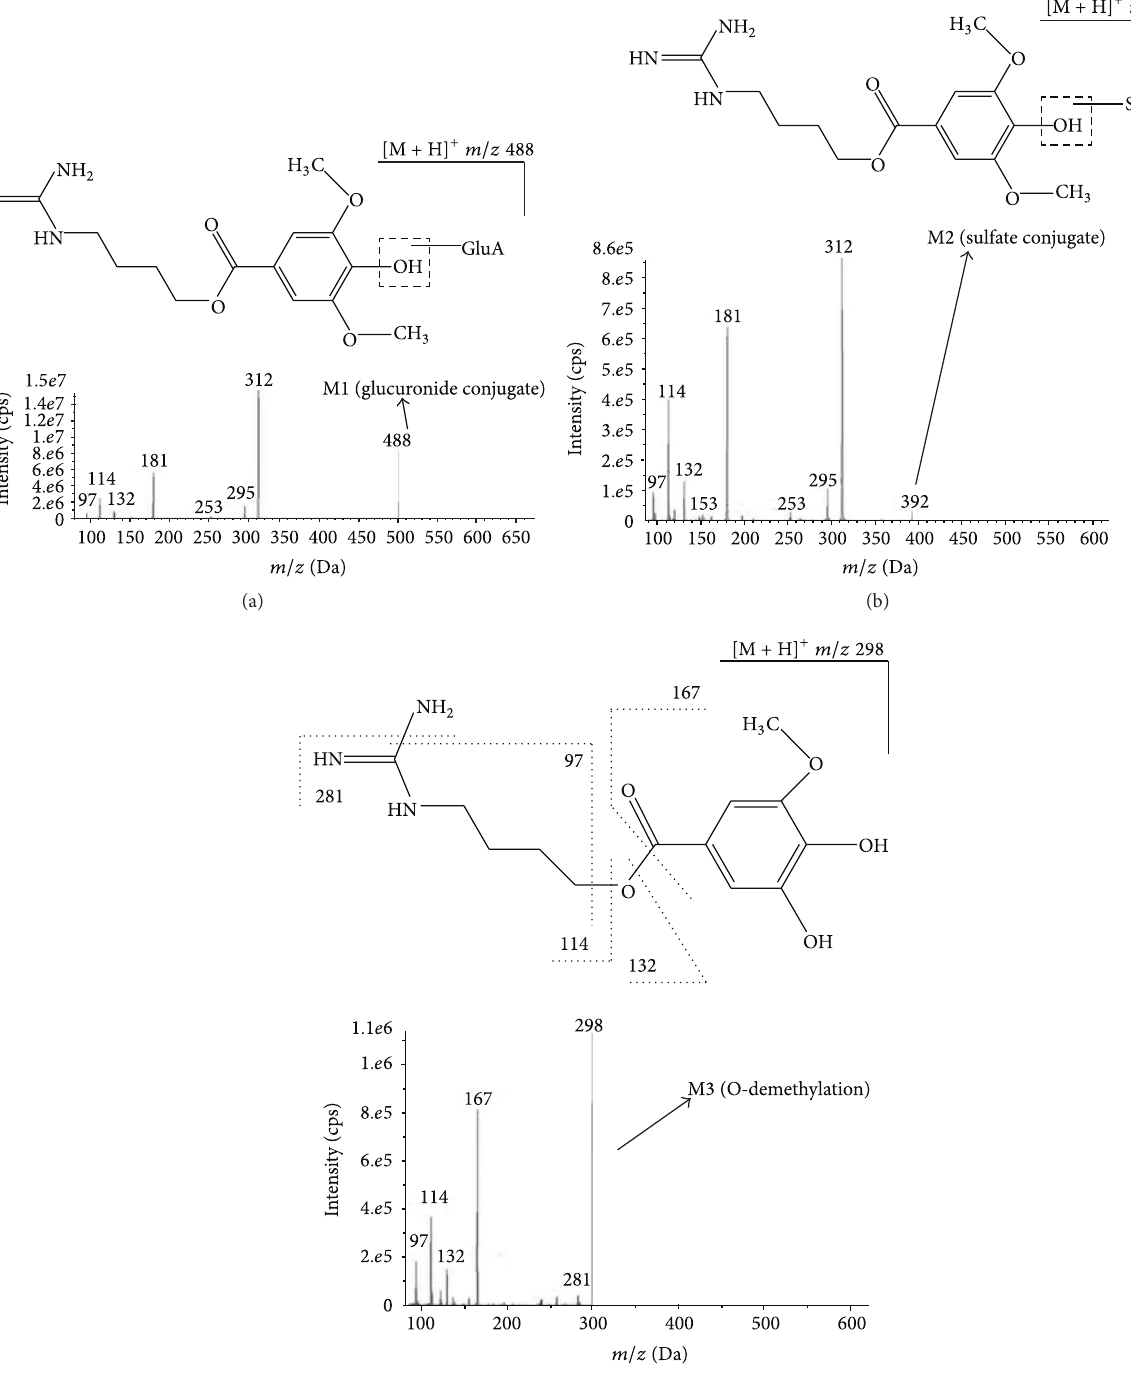
Figure 3: The MS 2 spectra and fragmentation pattern of three metabolites. (a) M1; (b) M2; (c)